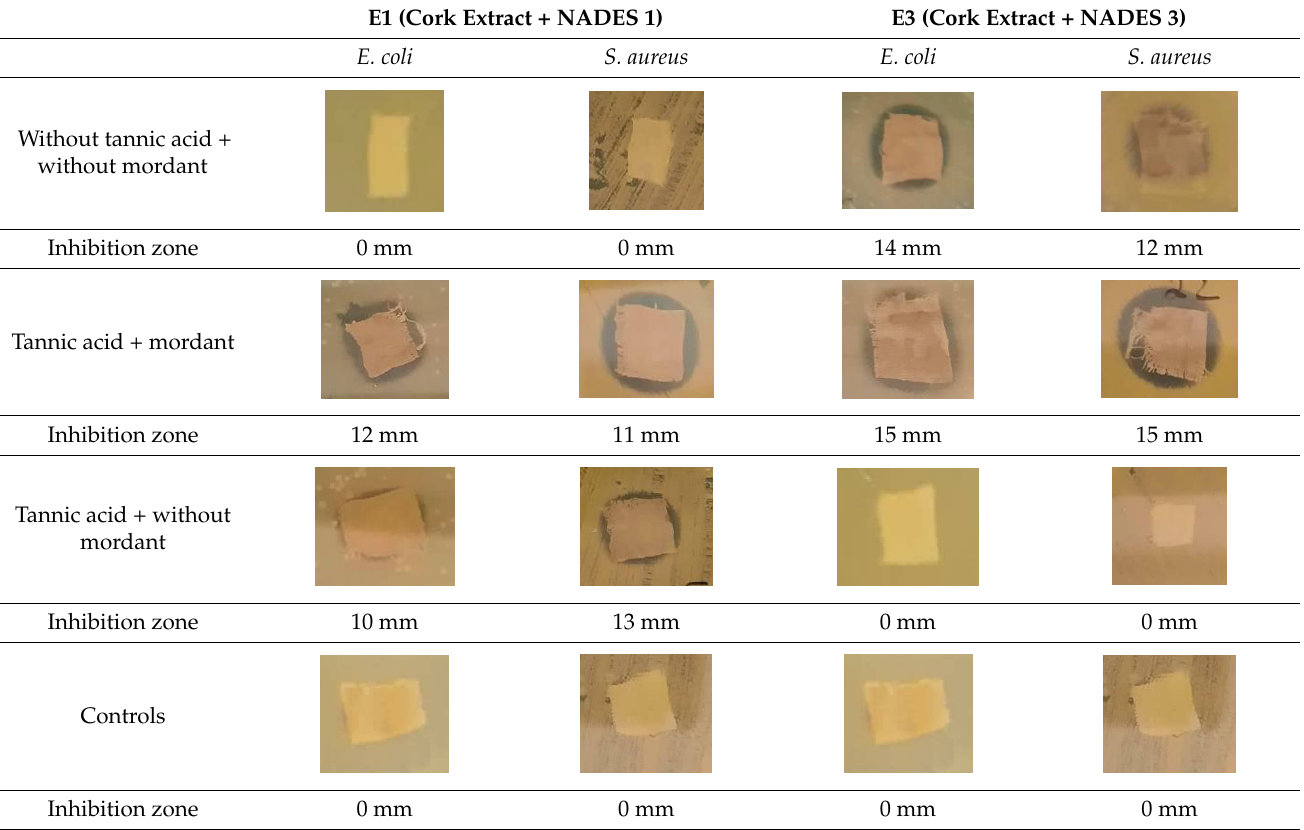
Table 8. Antimicrobial activity, expressed as inhibition zone (mm), of the cotton fabrics dyed with extract E1 and E3. Controls are raw cotton samples without dyeing with extracts.